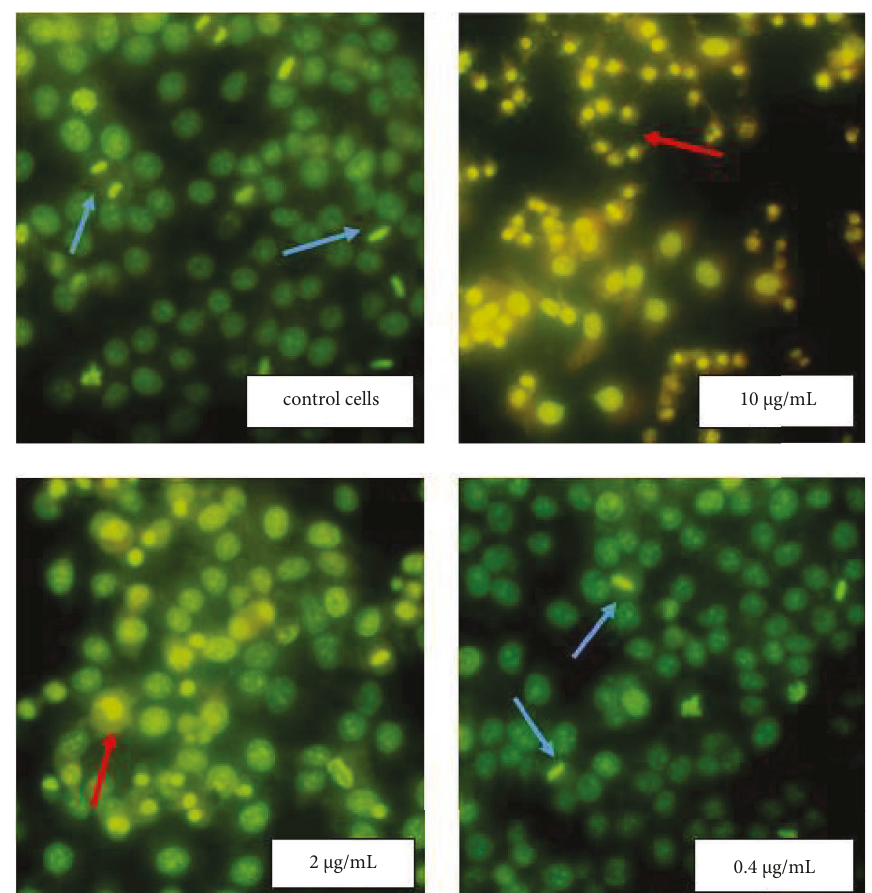
Figure 4: Morphological changes of Hep-2 cells exposure Ag NPs. The cells morphology after Ag NPs treatment were analyzed by fluorescent microscopy after staining with acridine orange. NPs at concentrations 10 and 2 μ g/mL lead to significant morphological changes in cancer Hep-2 cells such as pyknosis of nuclear chromatin and loses of the cytoplasm contents. Red arrows show necrotic cells and blue arrows − mitotic cells (280 × magnification).